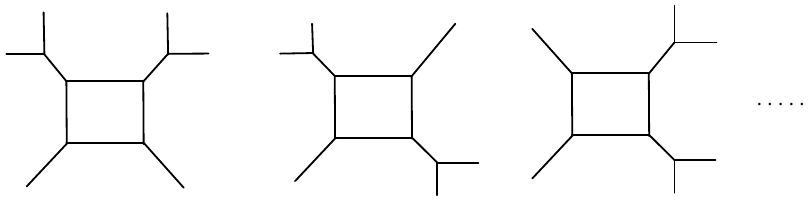
Figure 8 . Some equivalent 5d brane webs for the 5d N = 1 theory with the gauge group SU(2) and two fundamental hypermultiplets.